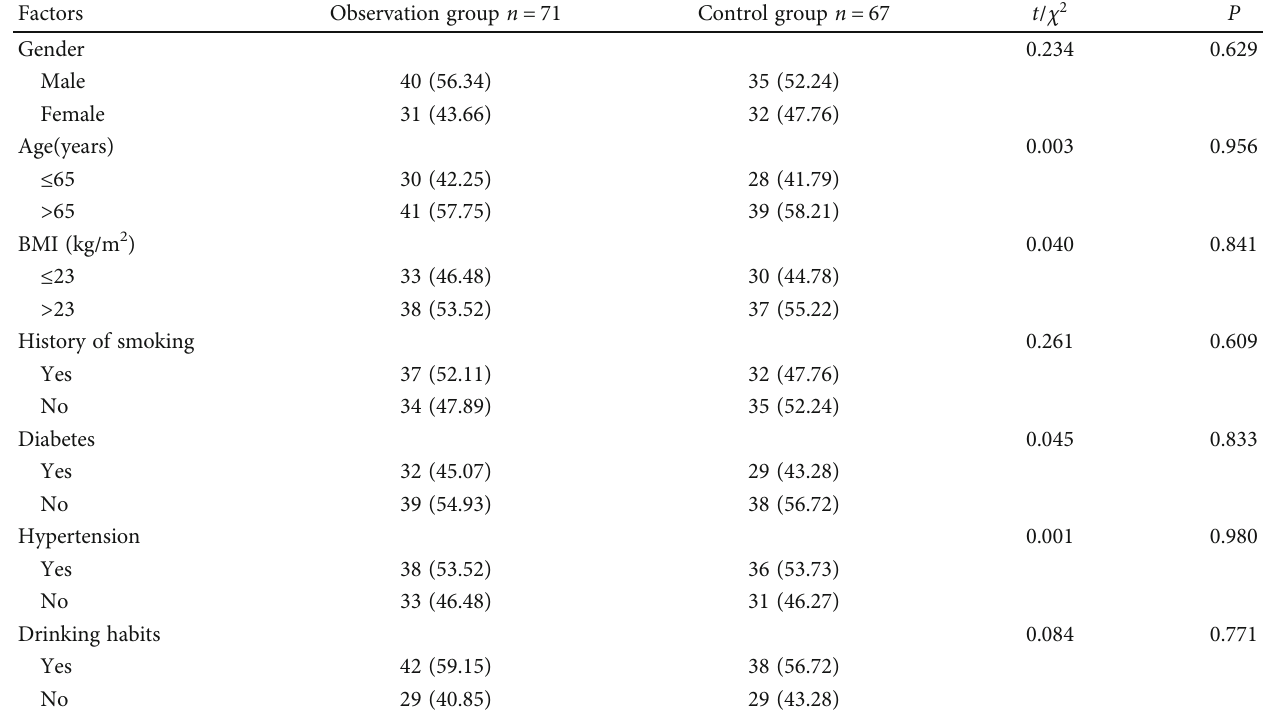
Table 1: General information [ n (%)].